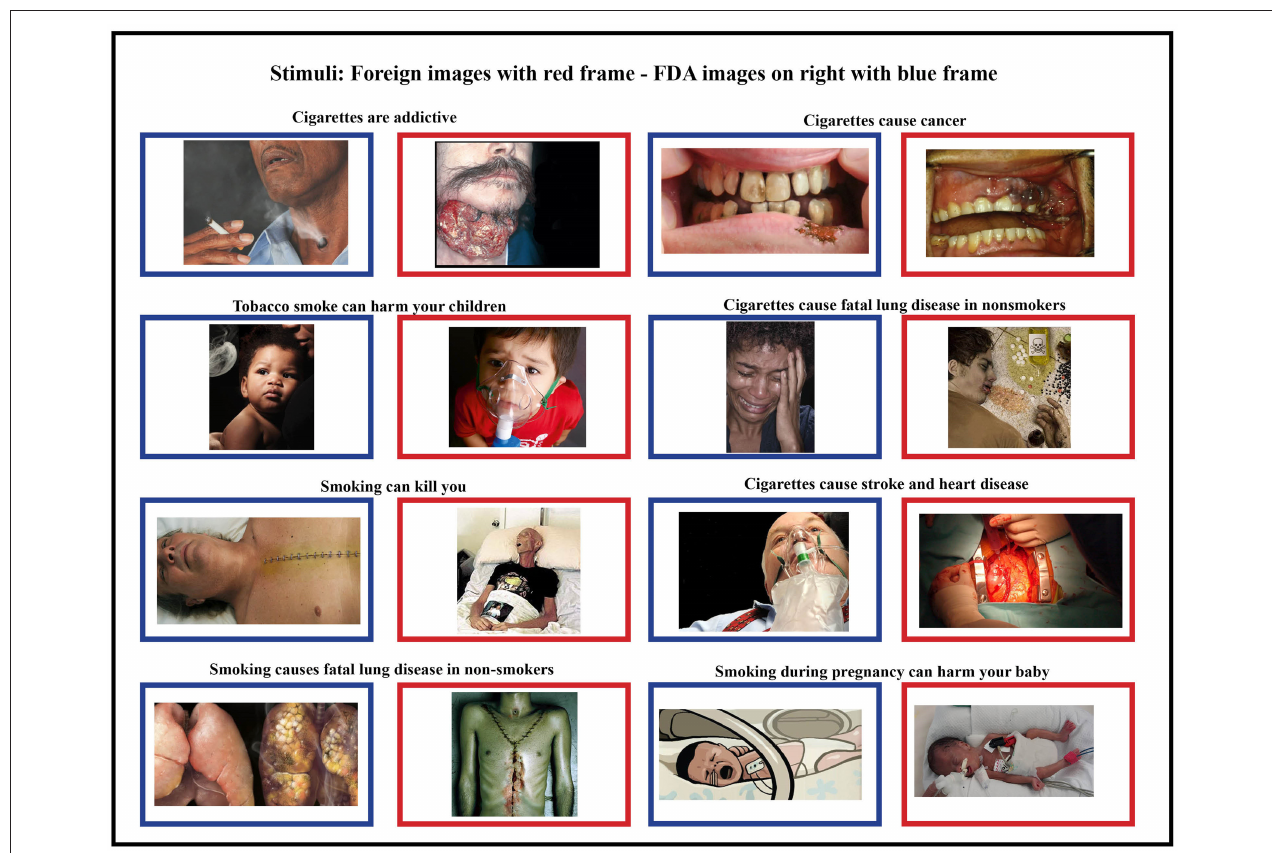
FIGURE 1 | Foreign stimuli (blue frames) and corresponding domestic stimuli (red frames) were matched for content and health topic. Foreign HWLs are generally thought to be more graphic than domestic (FDA) HWLs (5, 17).